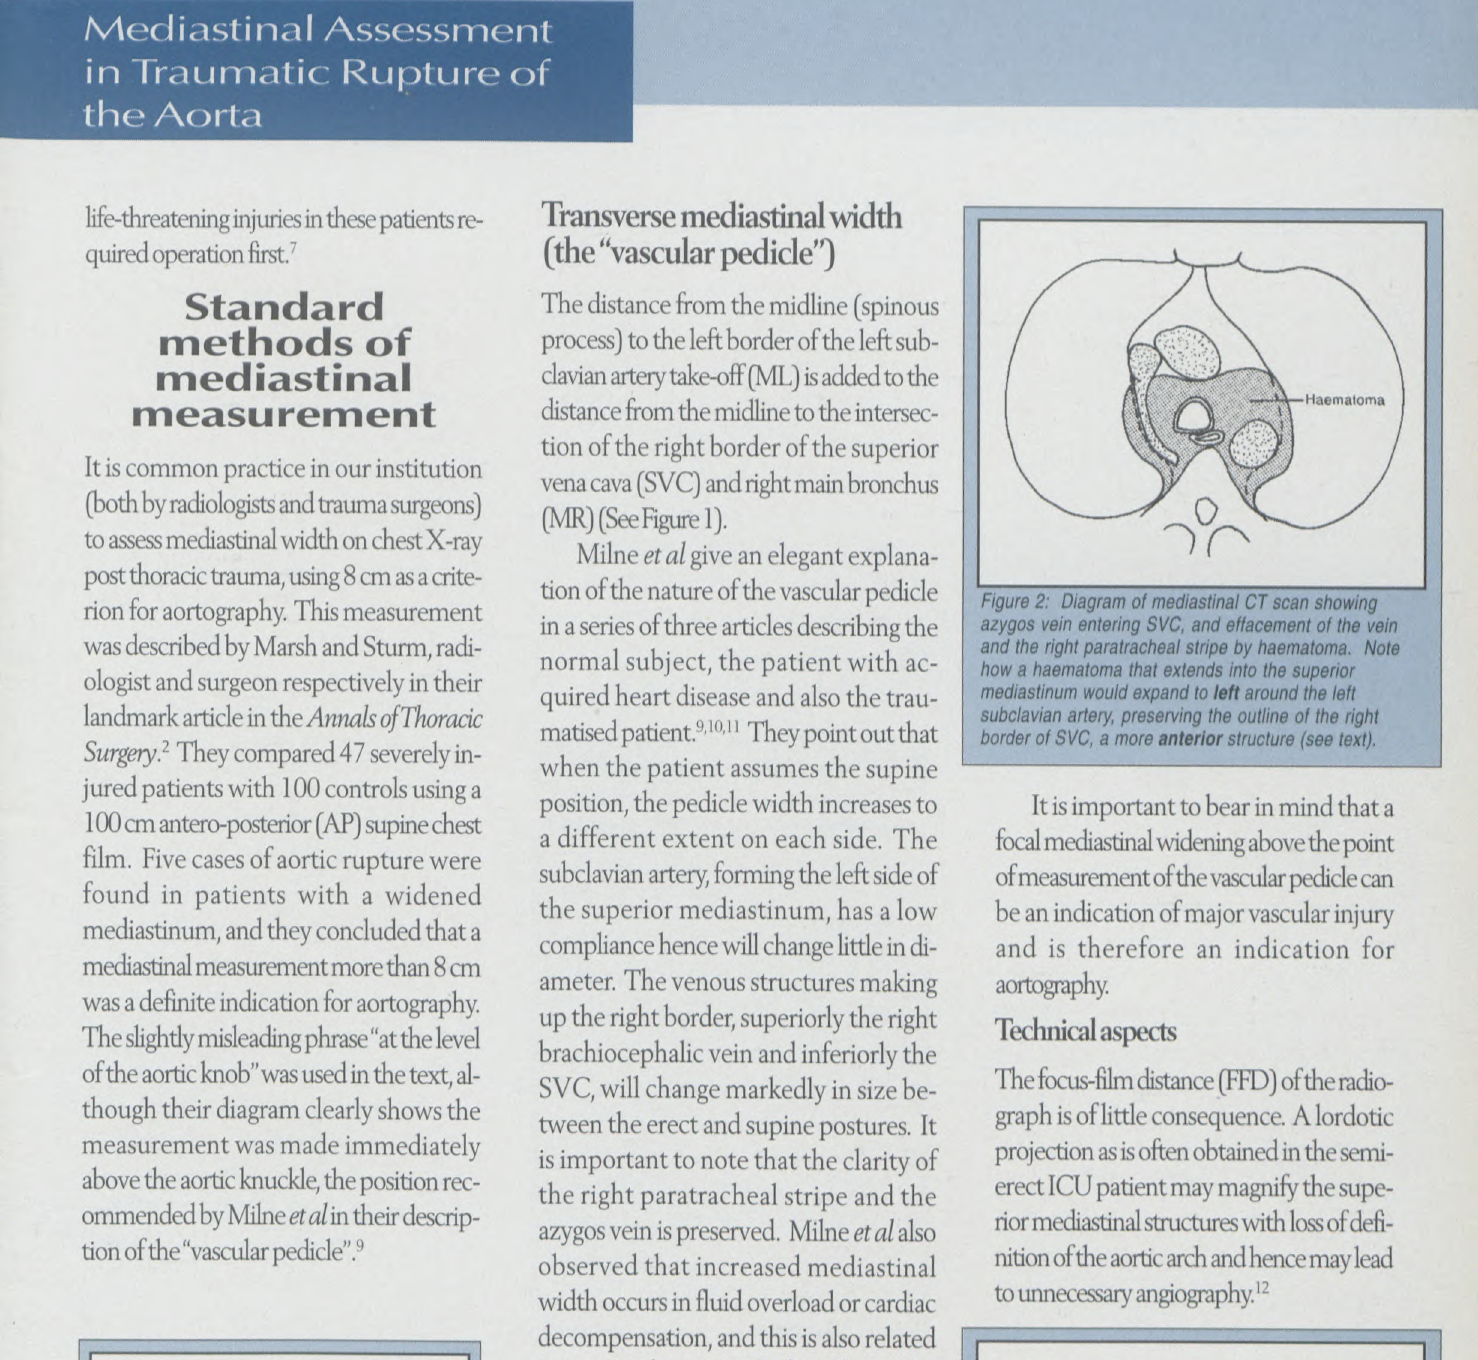
Figure 3: Diagram of chest radiograph to show delermination of mediaslinal width lo chest width ratio (MIG ratio) (see text).